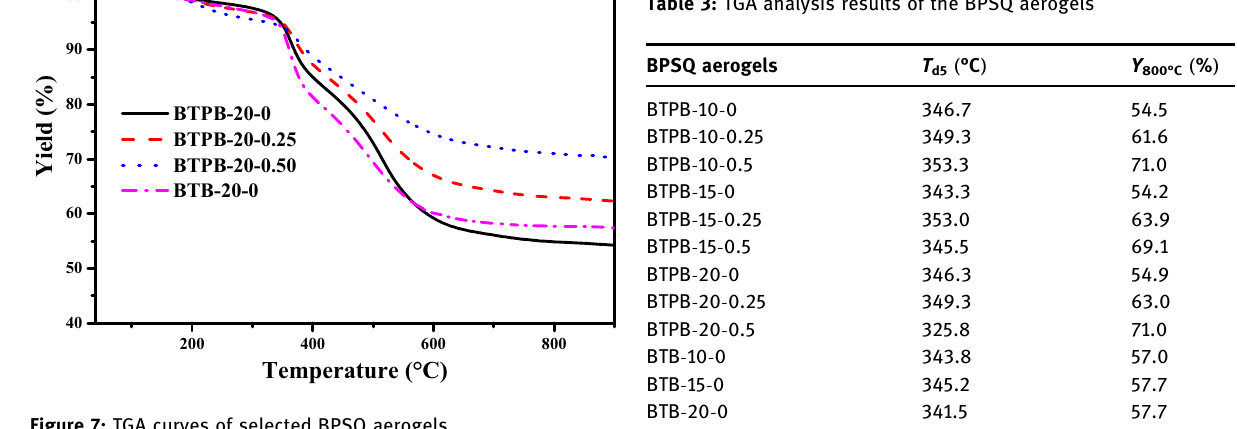
Table 3: TGA analysis results of the BPSQ